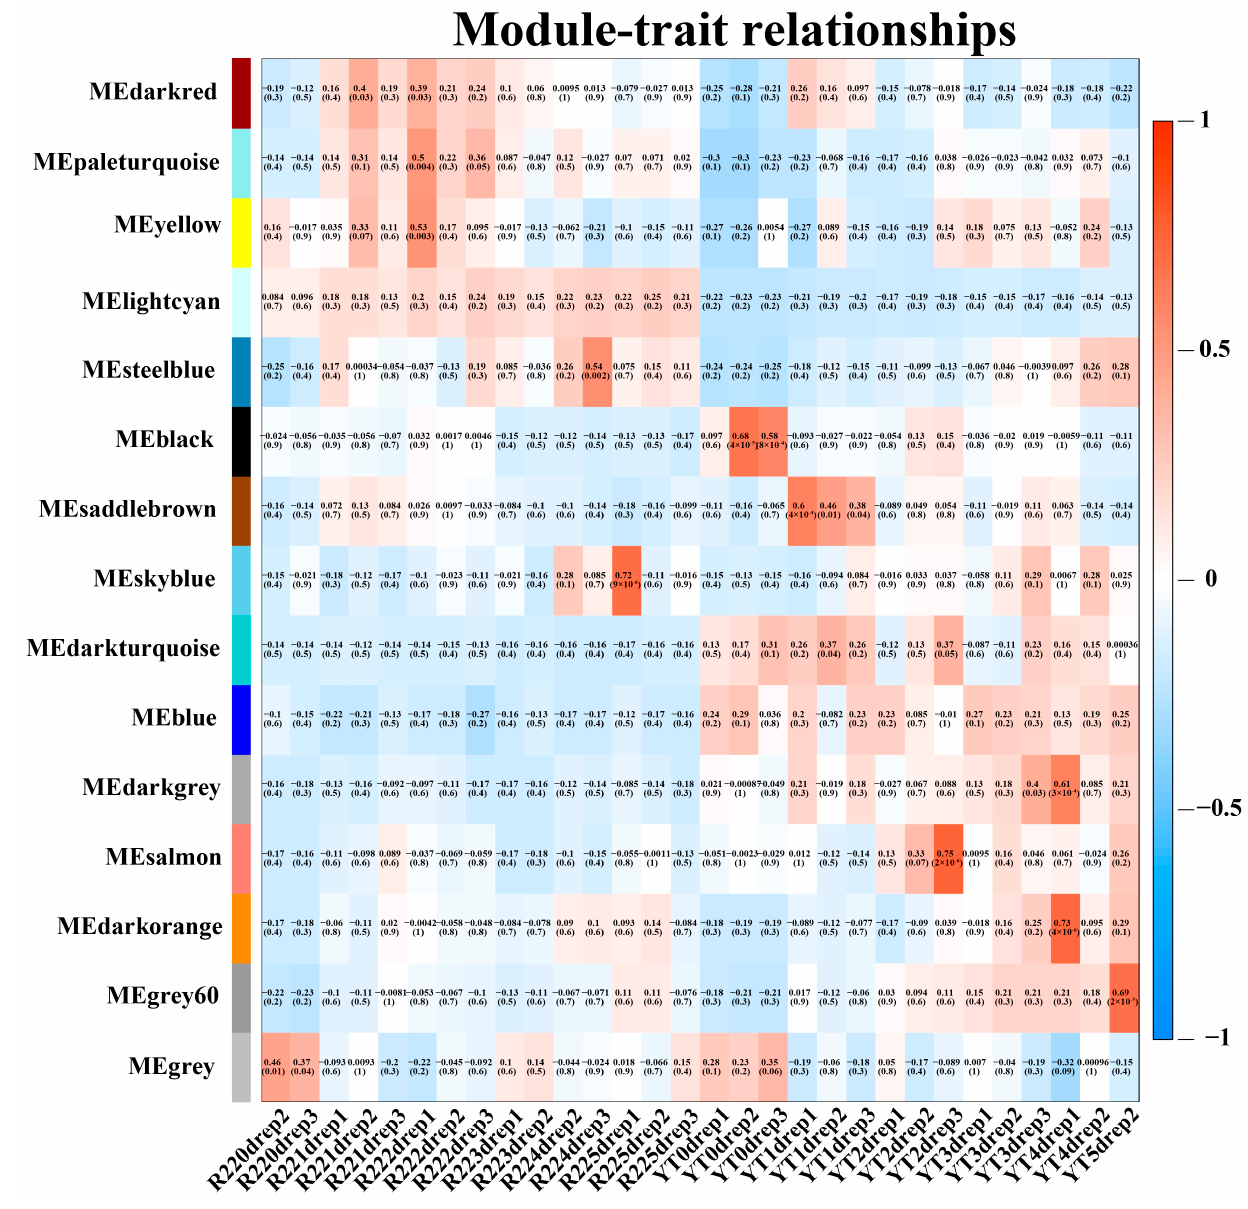
Figure 4. Module-trait associations revealed by Pearson correlation coefficient. The leftmost color column indicates different co-expression modules. The numbers in the figure indicate the correlation between the modules and traits, and the numbers in the parentheses are the correlation p value.